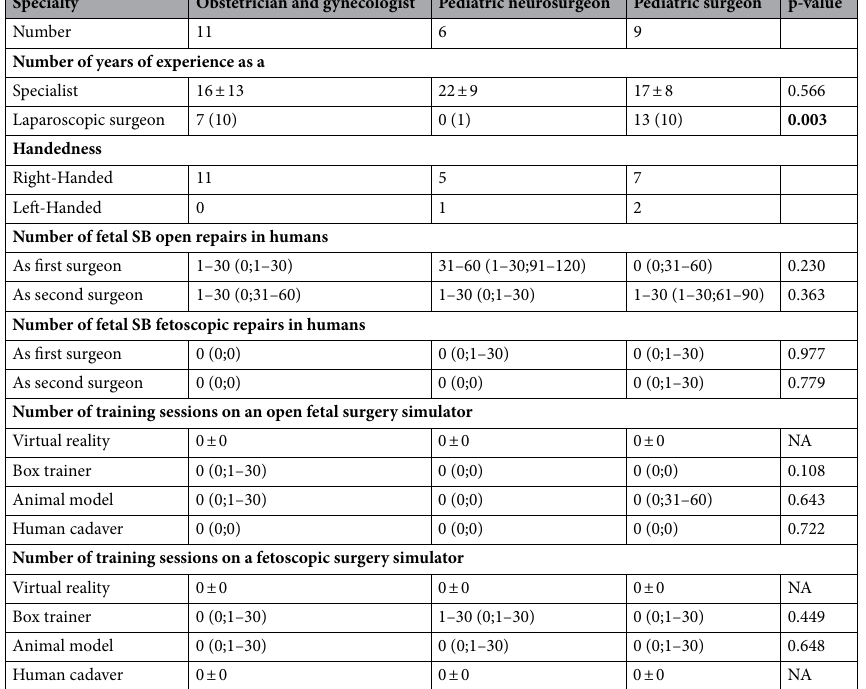
Table 1. Demographics of the three subspecialties involved in fetal surgery. Number of surgeries per specialty are displayed in median and range based on 5 block of 30 cases as per the online survey (0, 1–30, 31–60,